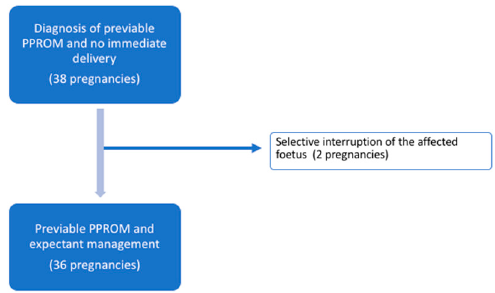
Figure 1. Flowchart of study population. Table 2. Perinatal and maternal outcomes of previable PPROM in